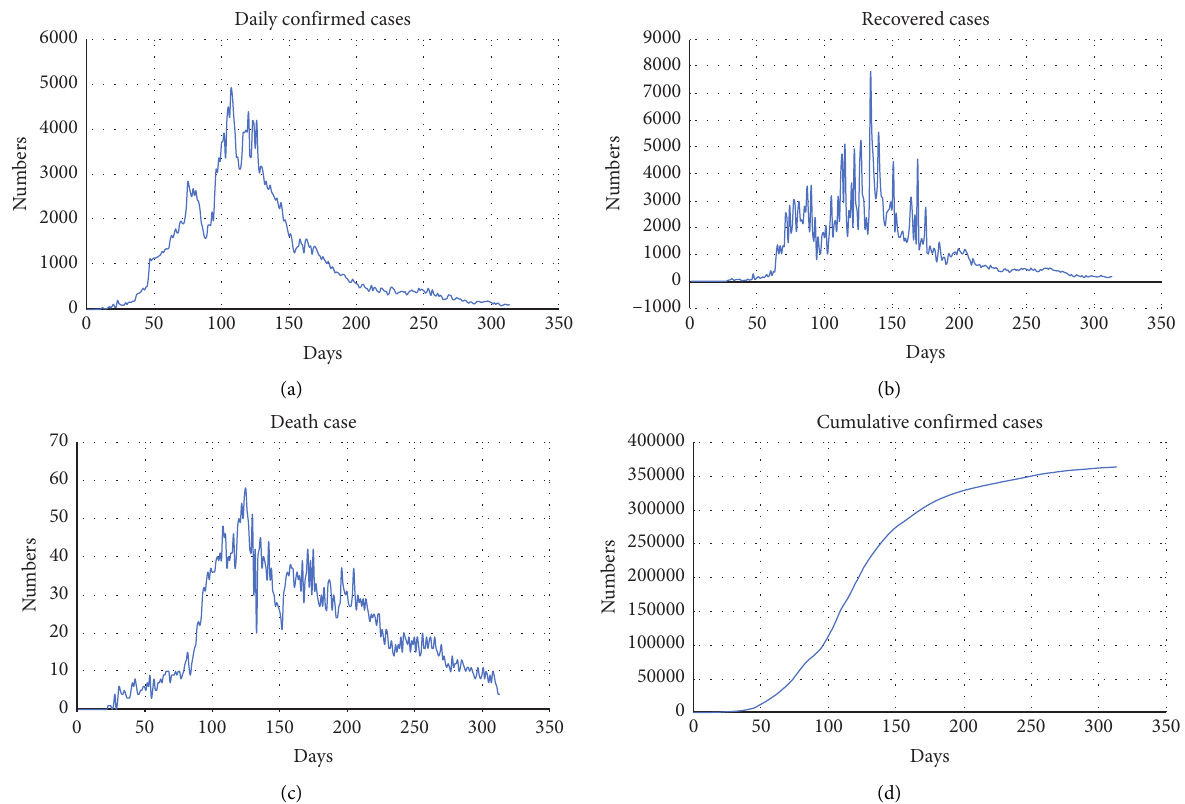
Figure 1: Number of (a) confirmed, (b) recovered, (c) death, and (d) cumulative confirmed cases due to COVID-19 in Saudi Arabia